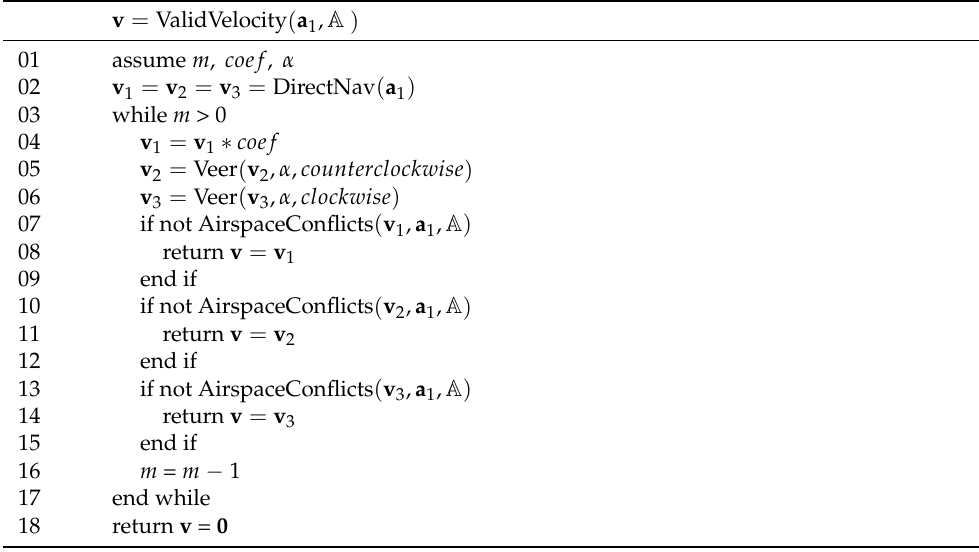
Table 4. Computation of a valid velocity for a UAV.